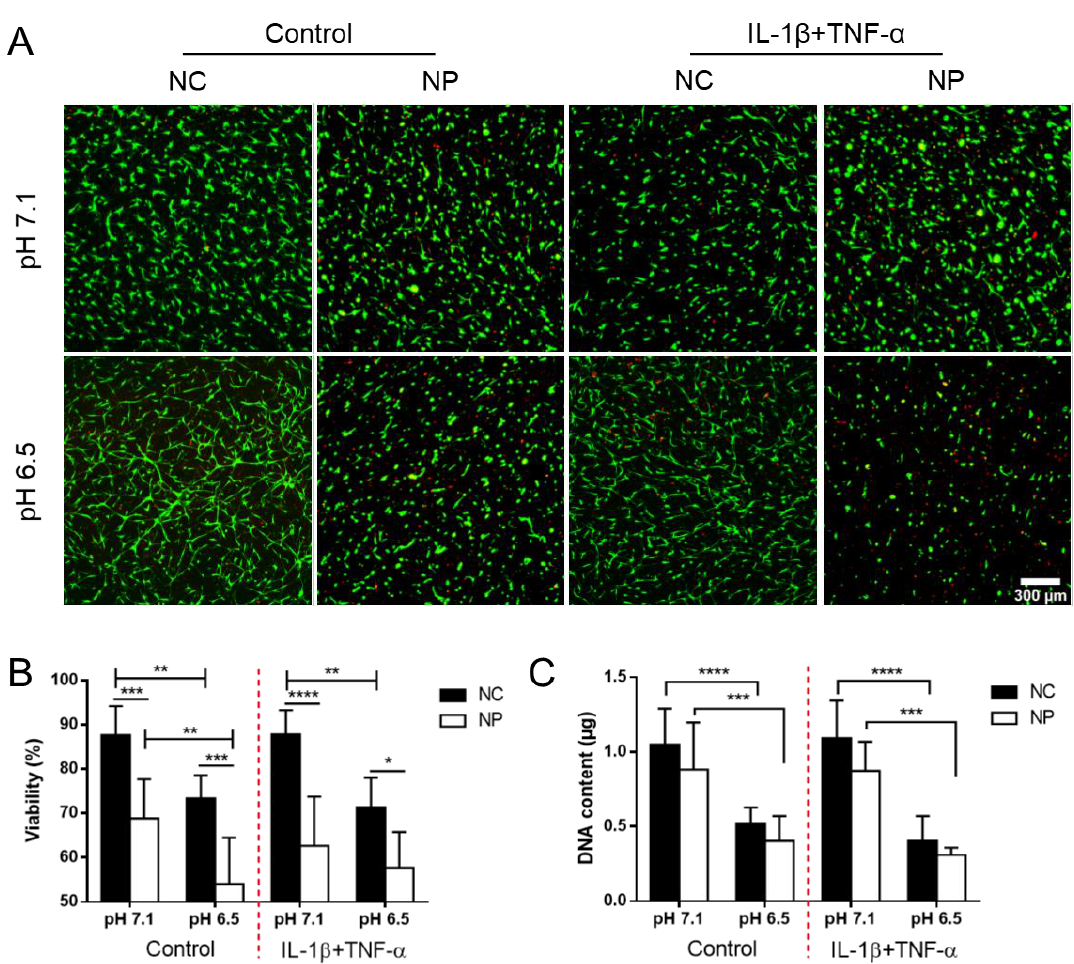
Figure 5. ( A ) Live/dead imaging at day 14 of NCs and NP cells in 3D hydrogel culture at different pH (7.1 and 6.5) and inflammatory cytokine (IL-1β+TNF-α) supplementation conditions. Scale bar is 300 μm. ( B ) Cell viability (%). ( C ) DNA content (μg) of hydrogels at day 14. * ( p < 0.05), ** ( p < 0.01), *** ( p < 0.001) and **** ( p < 0.0001) indicate significant differences between groups. N = 3 donors, n = 3 samples.